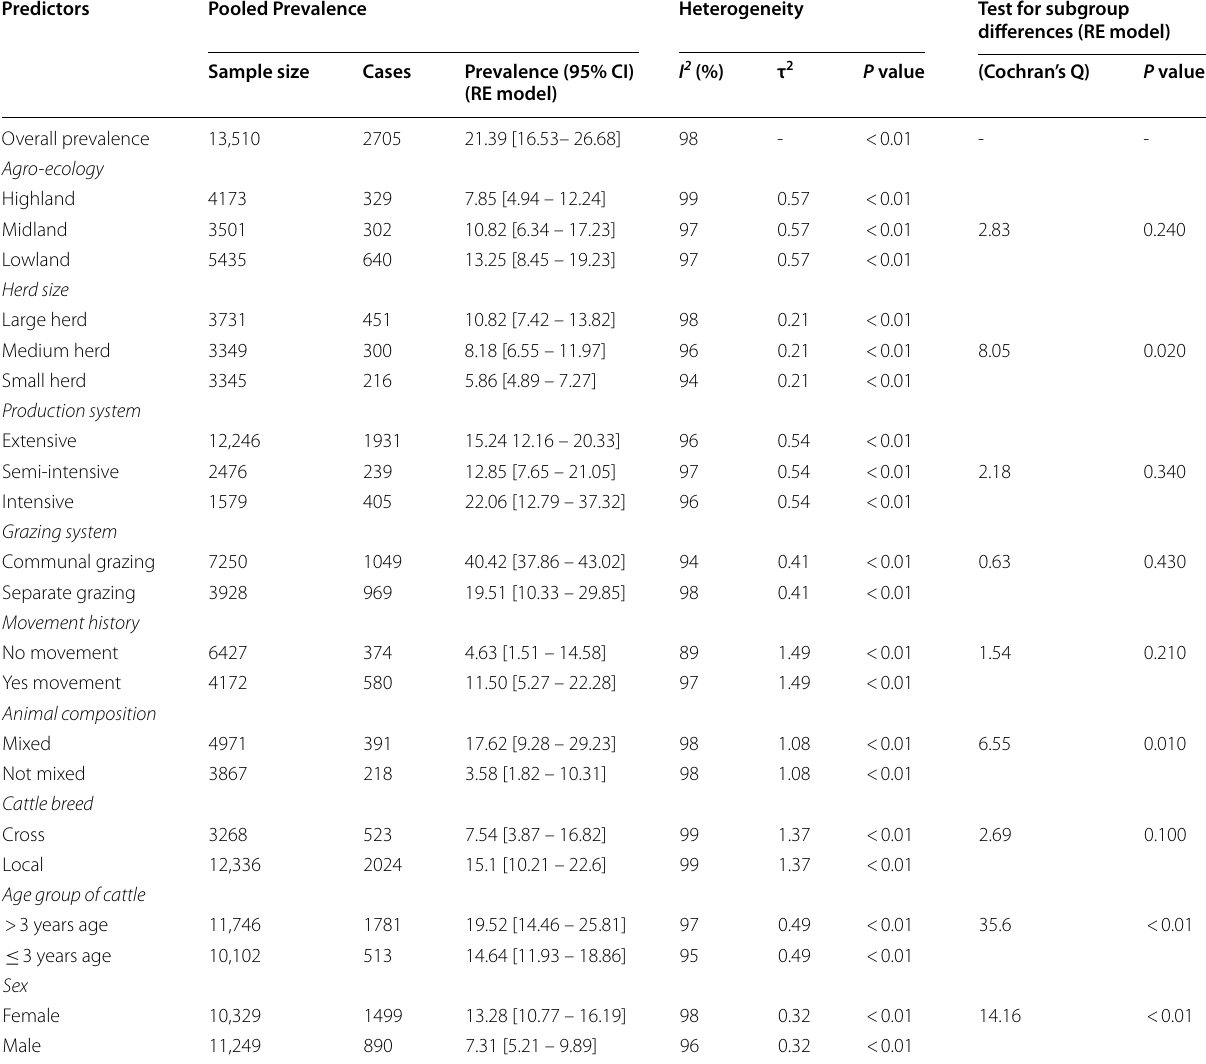
Table 2 Pooled prevalence estimates of foot and mouth disease, stratified by sub-groups